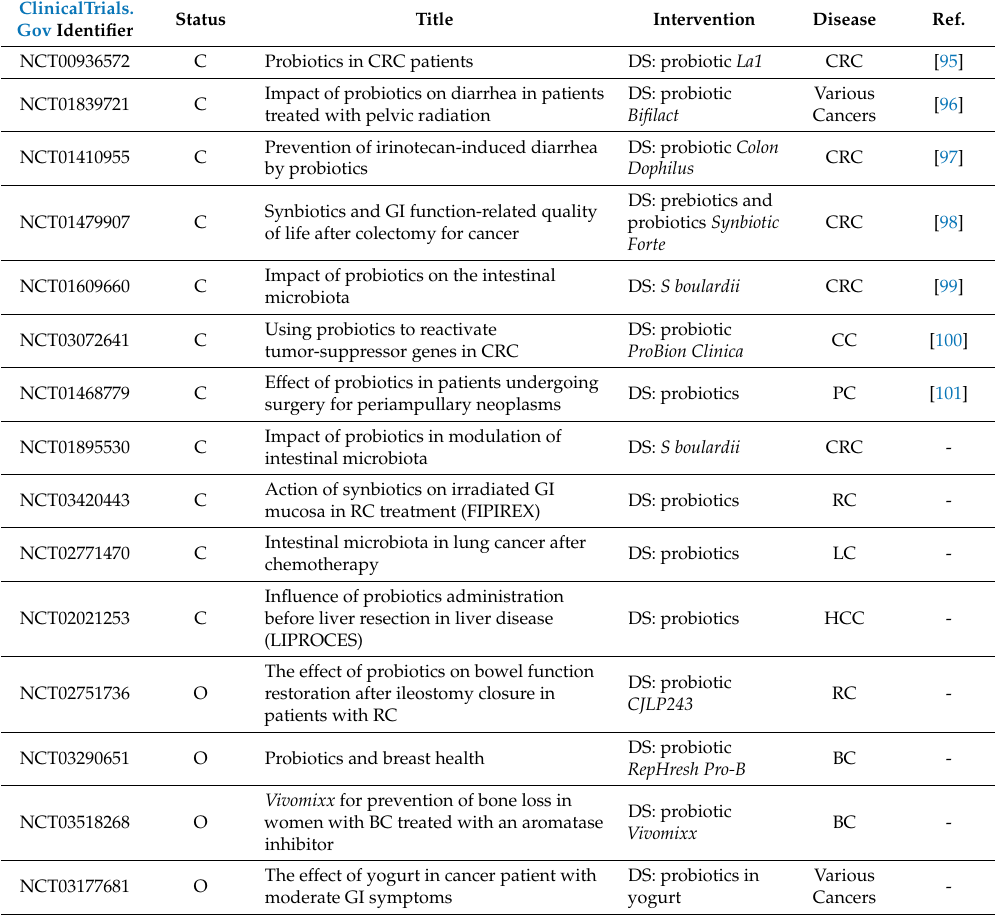
Table 1. Clinical trials * describing the efficacy of probiotics dietary supplementation and/or FMT in cancer